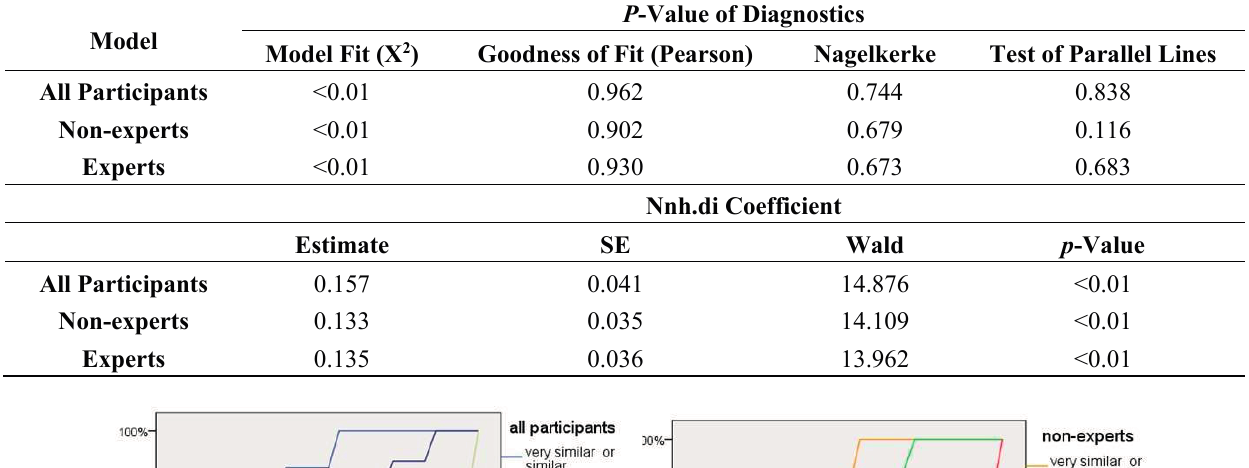
Table 5. Diagnostics and coefficient results for each ordinal logistic regression model.